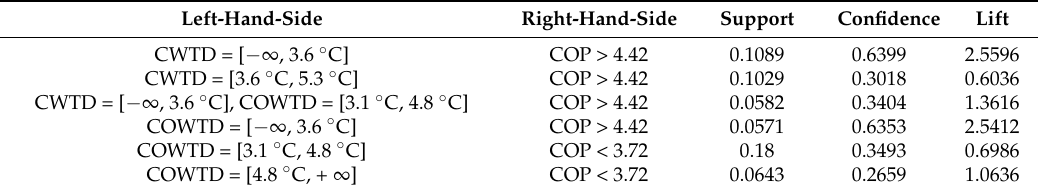
Table 4. Expected rules.